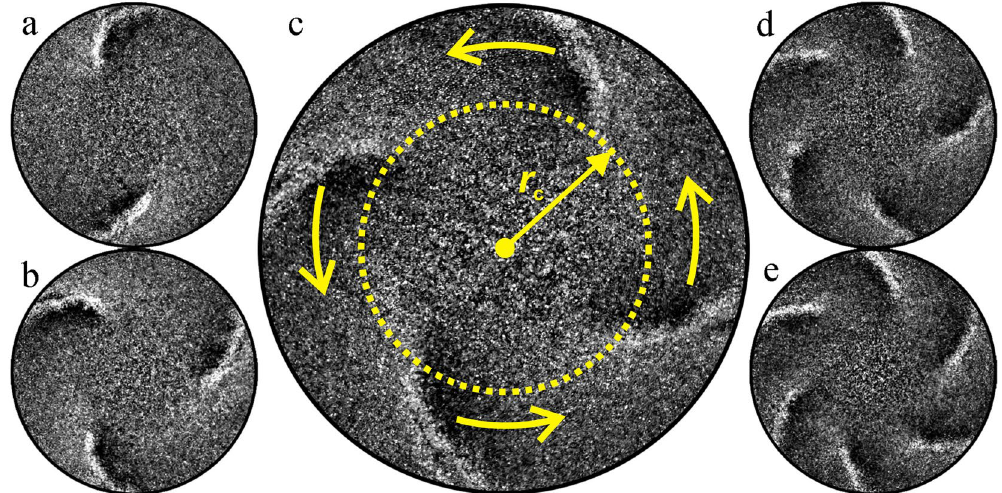
Figure 1. Top-view snapshots of DWFs, which propagate along the rim of the container (thick black circle), in an oscillated wet granular layer. ( a – e ) Representative snapshots for two to six curved fronts. In ( c ), the arrows show the propagation direction of the wave fronts and the dashed circle marks the region in which no DWFs